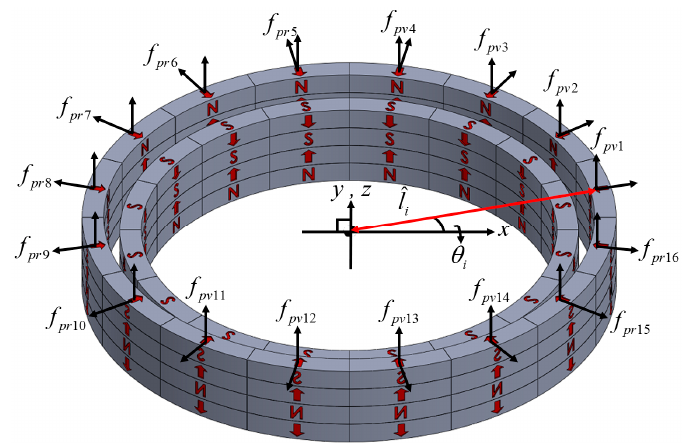
f of 16 sets of passive magnetic units about pv